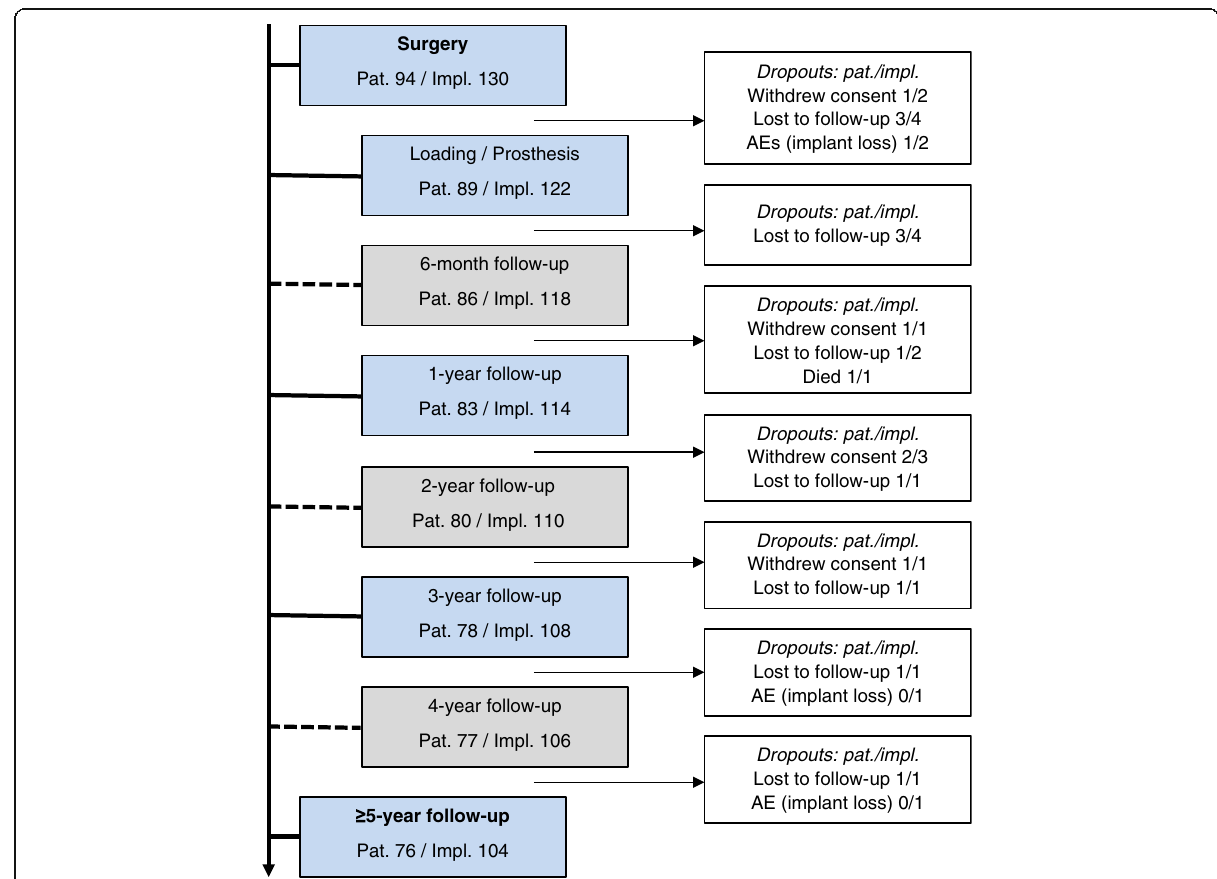
Fig. 1 Study flow-chart: assessments and reason for dropouts. Study visits were done according to standard procedures in the respective study centers. Blue, mandatory visits; gray, optional